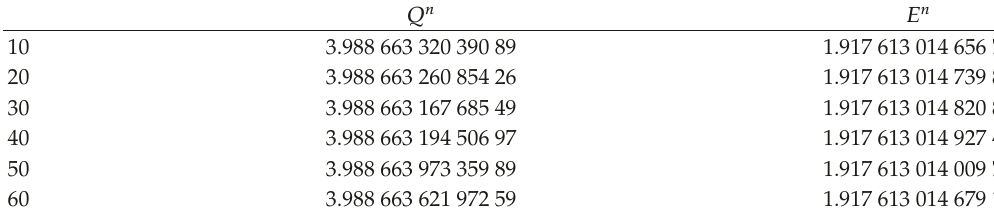
Table 6: Discrete mass Q n and discrete energy E n with τ (cid:7) h (cid:7) 0 . 1 at various t for p (cid:7)